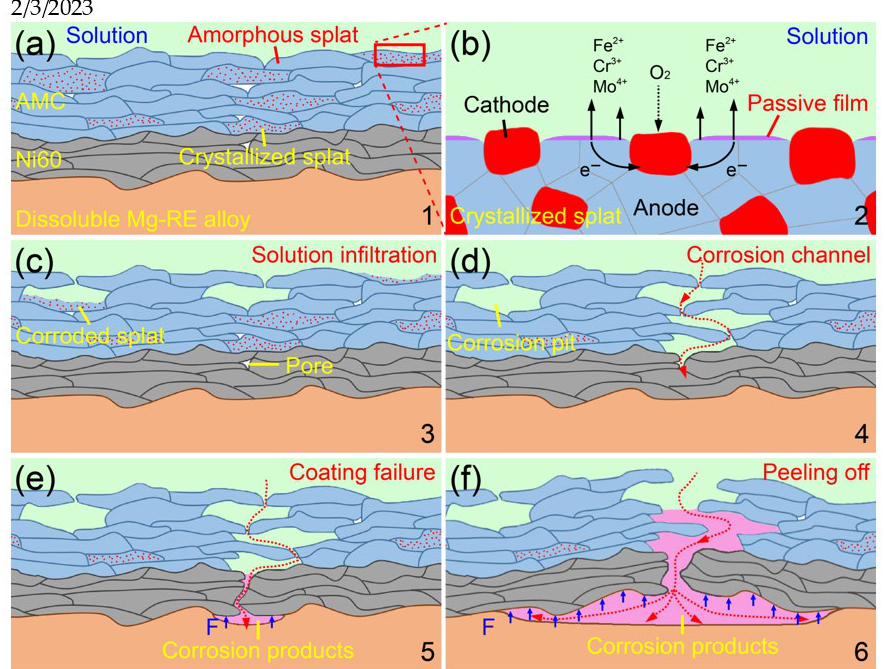
Figure 10. Schematic diagrams showing the corrosion mechanism of the AMCs on dissolvable Mg-RE alloy substrates: ( a ) uncorroded AMCs, ( b ) micro-galvanic corrosion of crystallized splats, ( c ) solution infiltration, ( d ) formation of corrosion channels, ( e ) coating failure and ( f ) peeling off of AMCs.